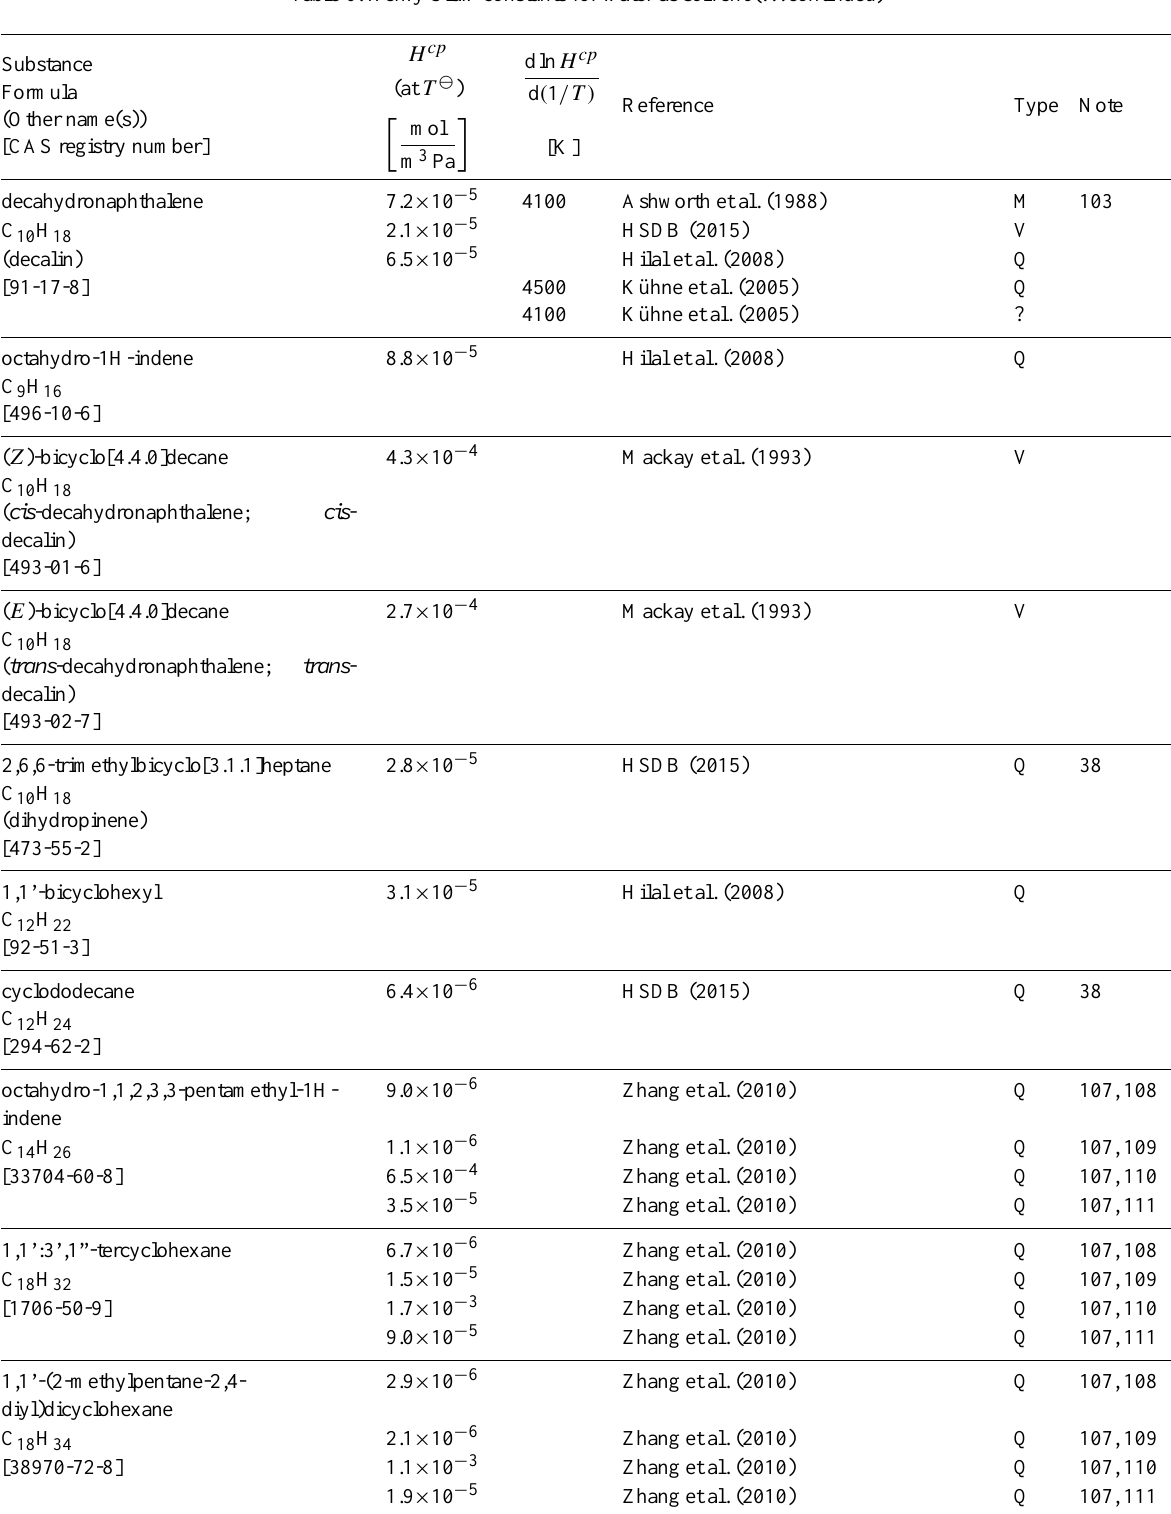
Table 6: Henry’s law constants for water as solvent